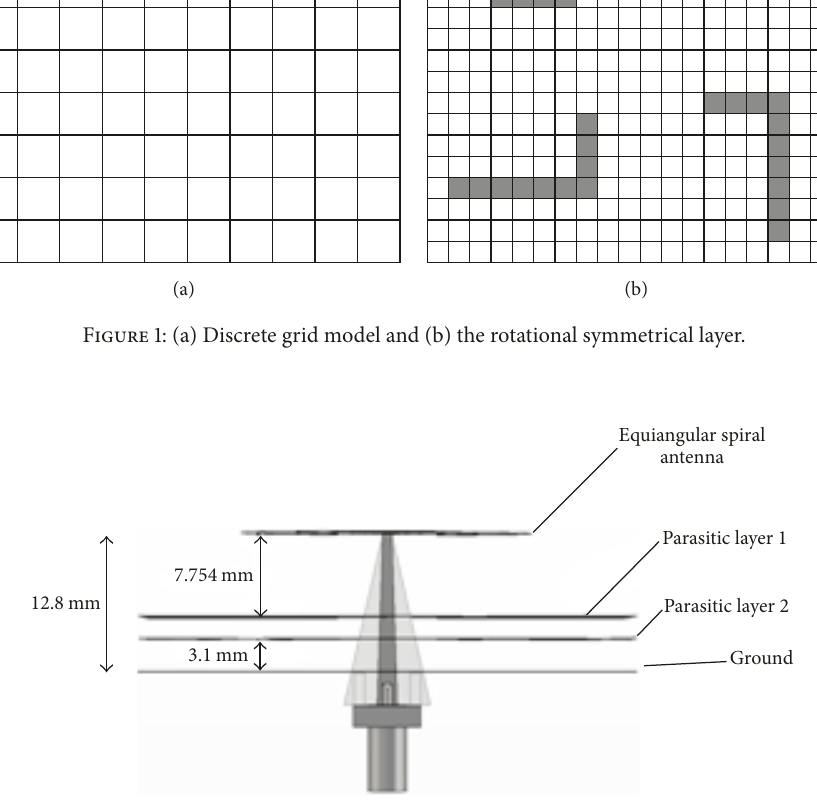
Figure 2: Side view of the basic